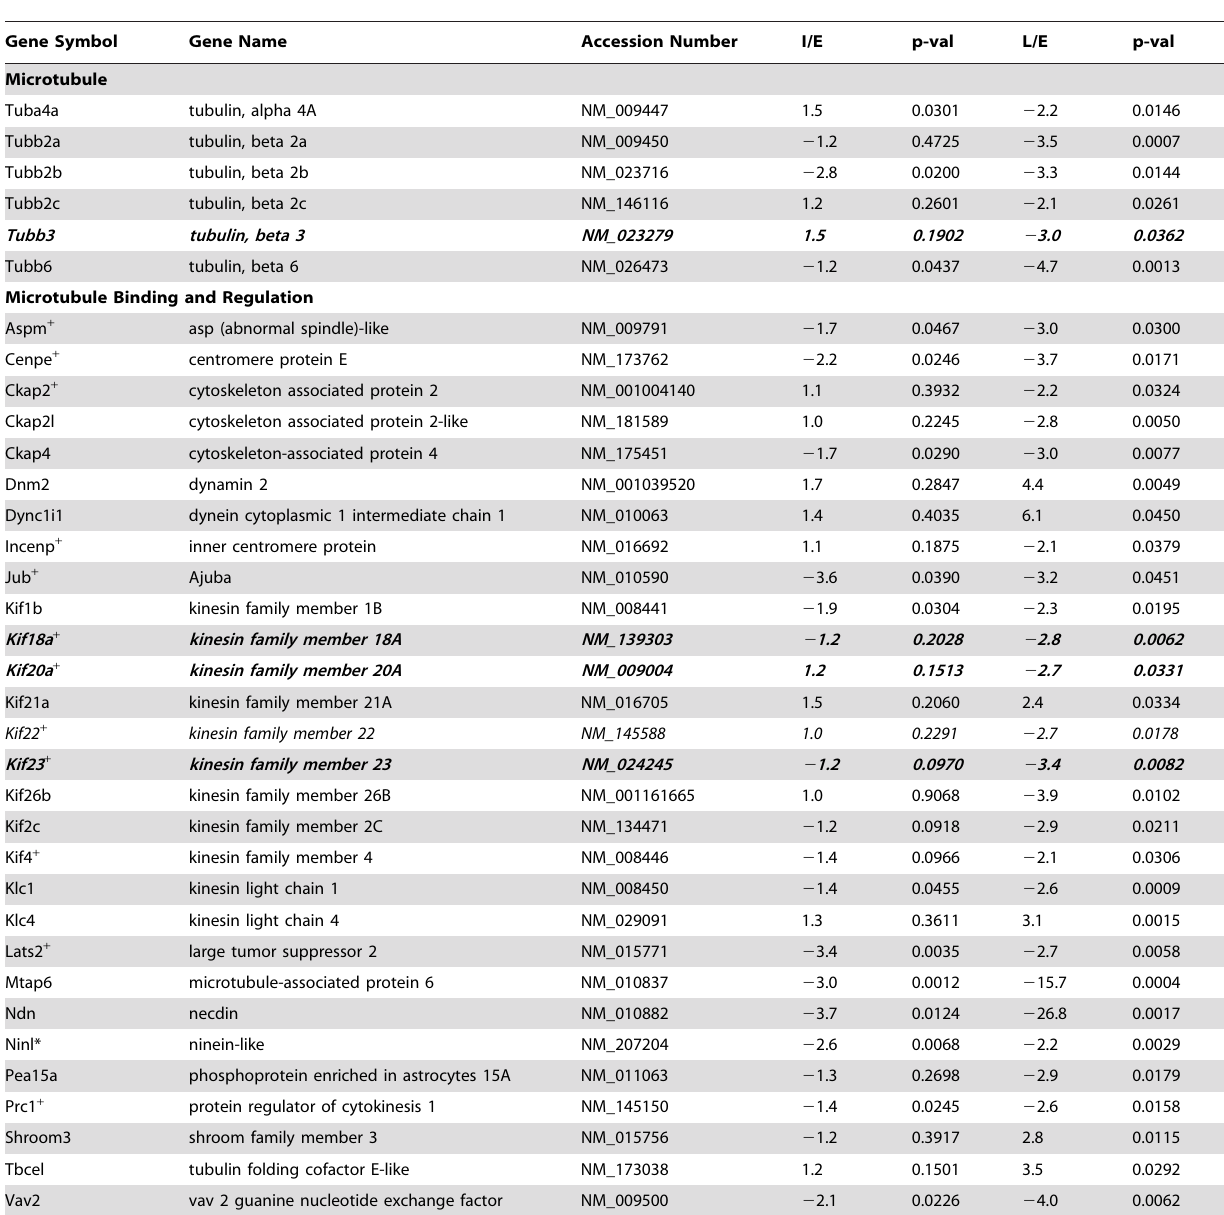
Table 4. Differentially Expressed Microtubule and Microtubule Associated Genes in MOSE cell